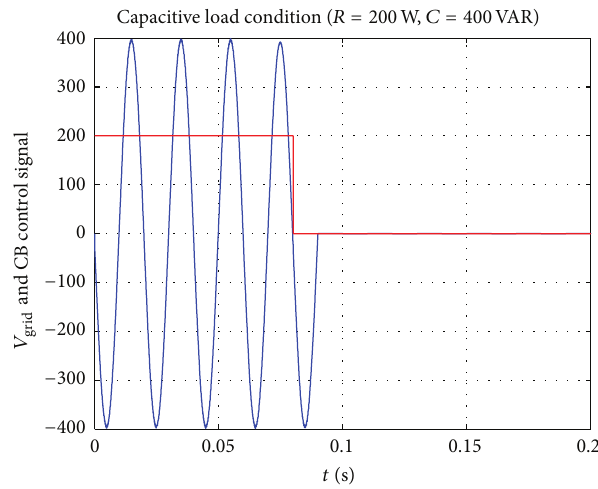
Figure 11: The capacitive load condition (200 W and 𝑄 𝐶 = 400 VAR).